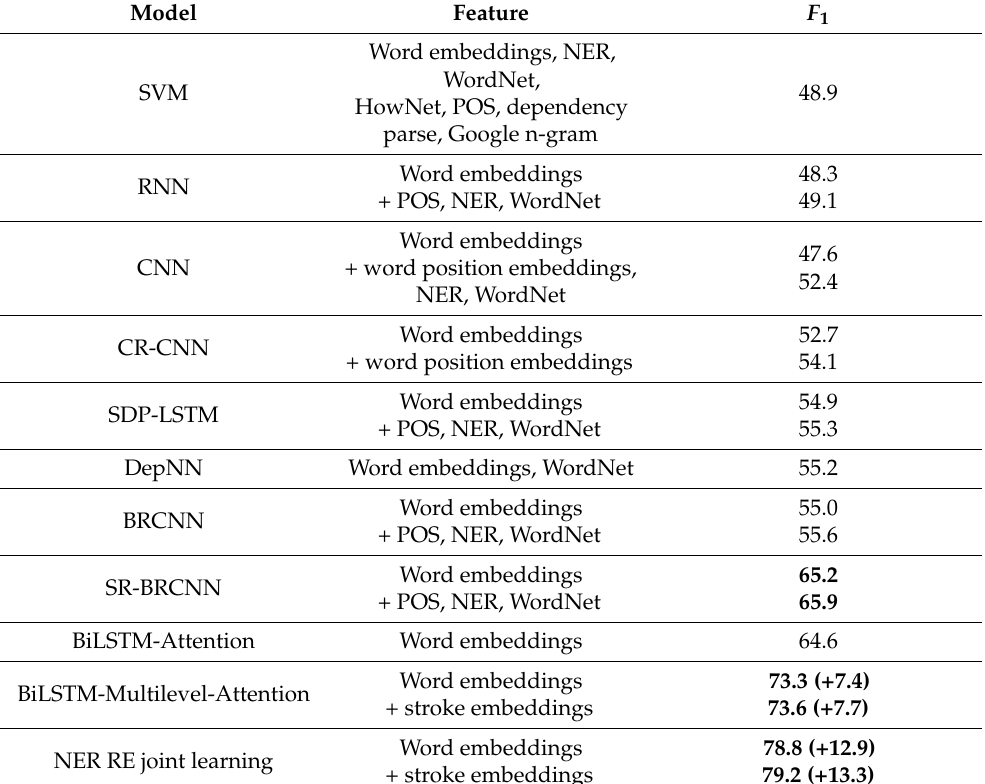
Table 6. Results of relation